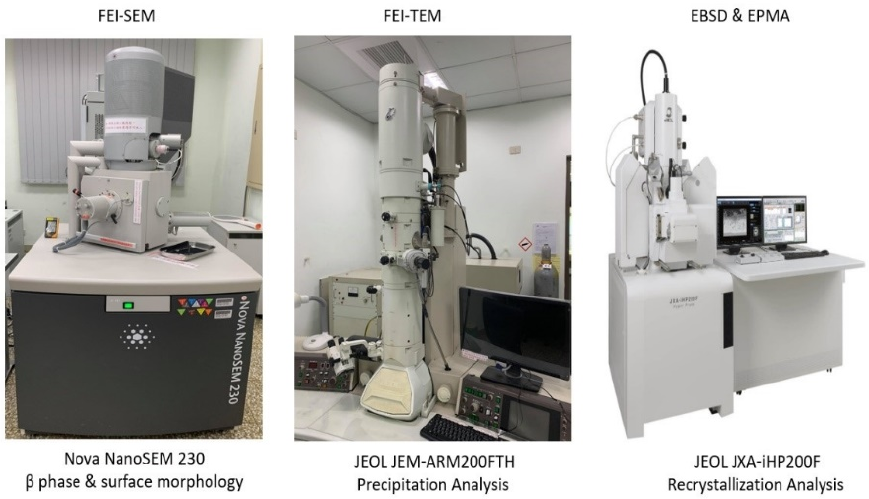
Figure 1. Experimental equipment for Al-5Mg alloy.